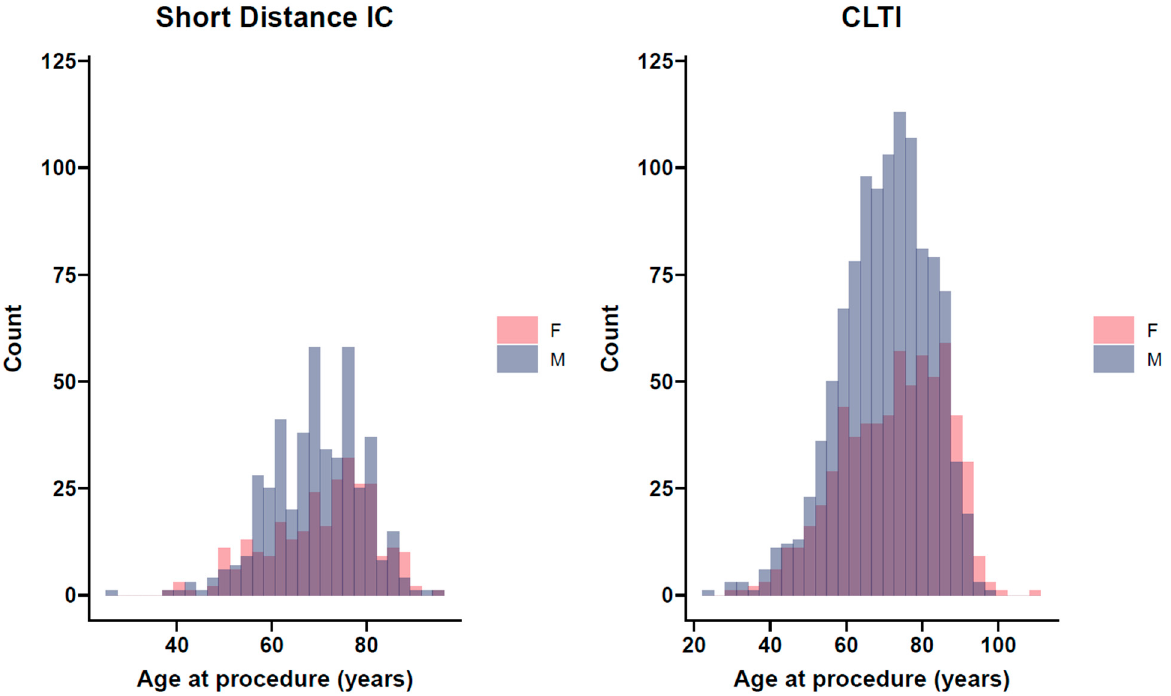
Figure 2. Histogram of age at first presentation of short-distance IC and CLTI as stratified by sex. There appears to be a decrease in the age- and sex-standardized median age for female and males at first PAD-related limb procedure from 2010 to 2021; however, there is considerable overlap of IQR, hence no trend is discernable (Figure 3).